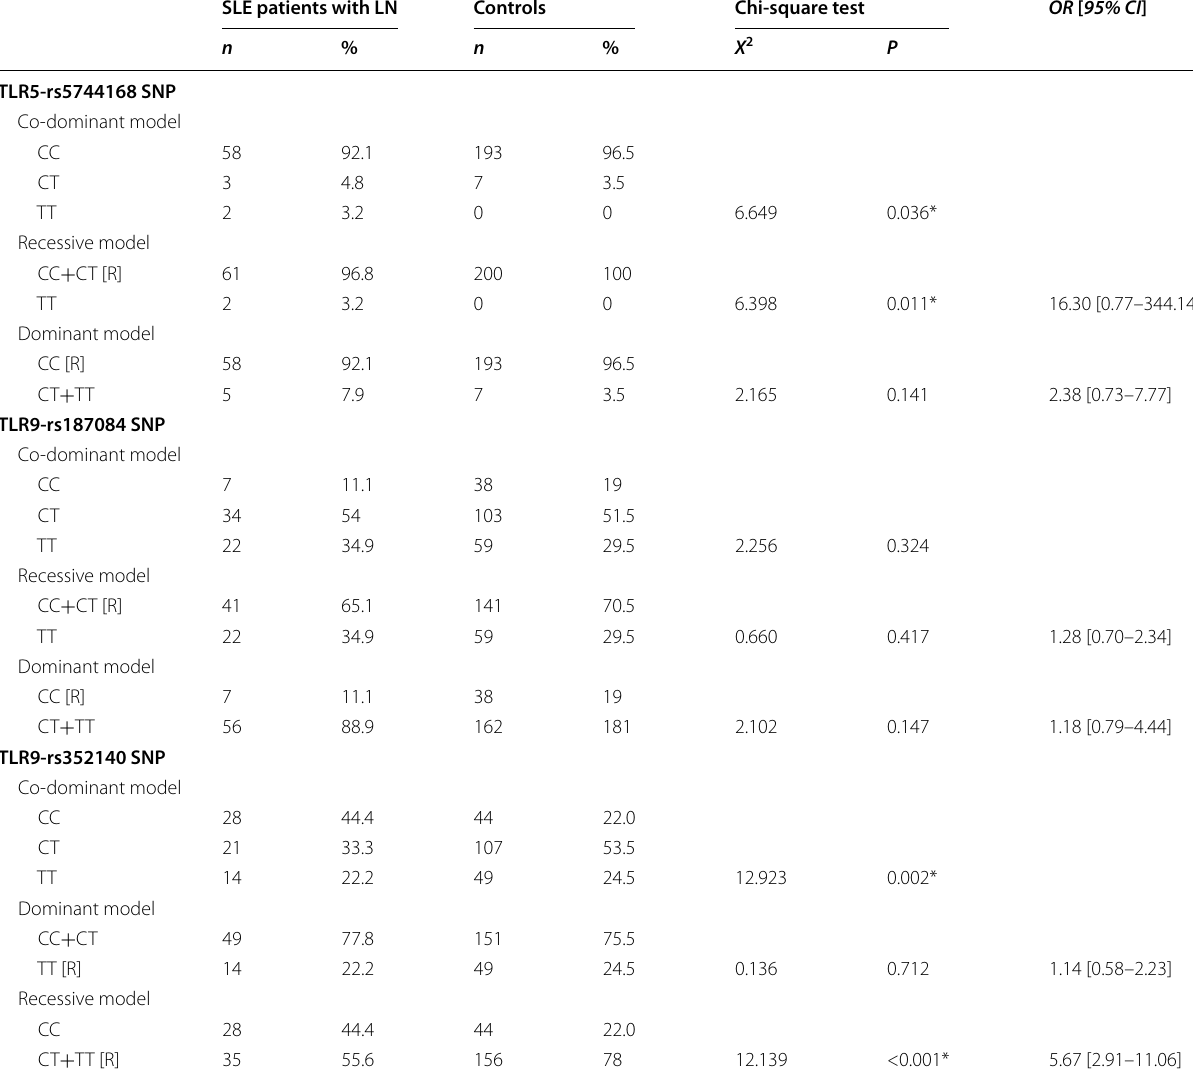
Table 4 Comparison of genotyping distribution of TLR9 gene SNP rs187084 and TLR5 gene SNP rs5744168 between LN patients and controls SLE patients with